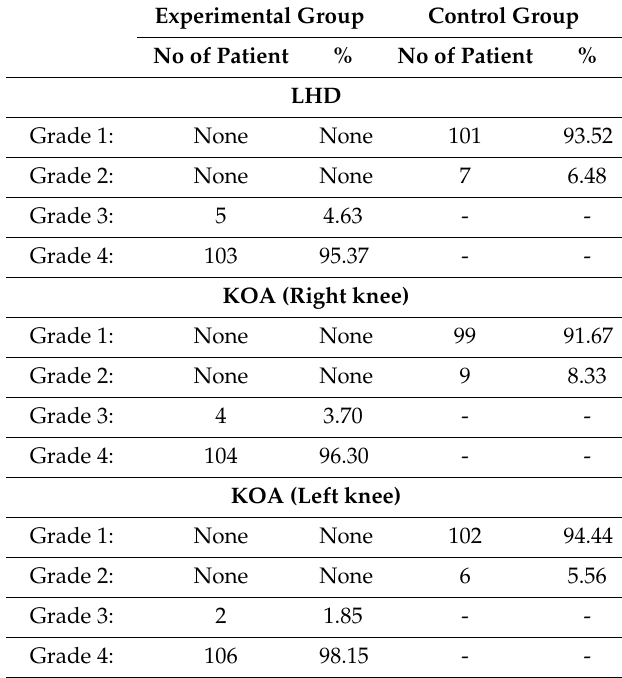
Kellgren–Lawrance (KL) Grading scales for lumbar herniated disc (LHD) and knee-osteoarthritis (KOA) of experimental and control